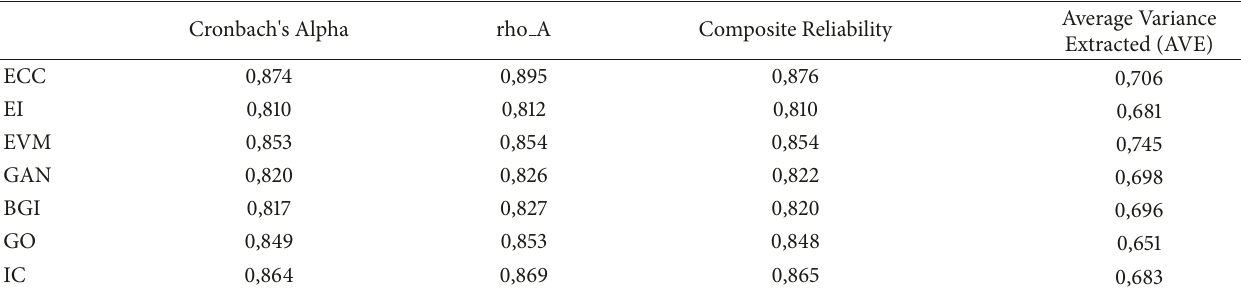
Table 3: Cronbach Alpha, rho A, Composite Reliability, and AVE.